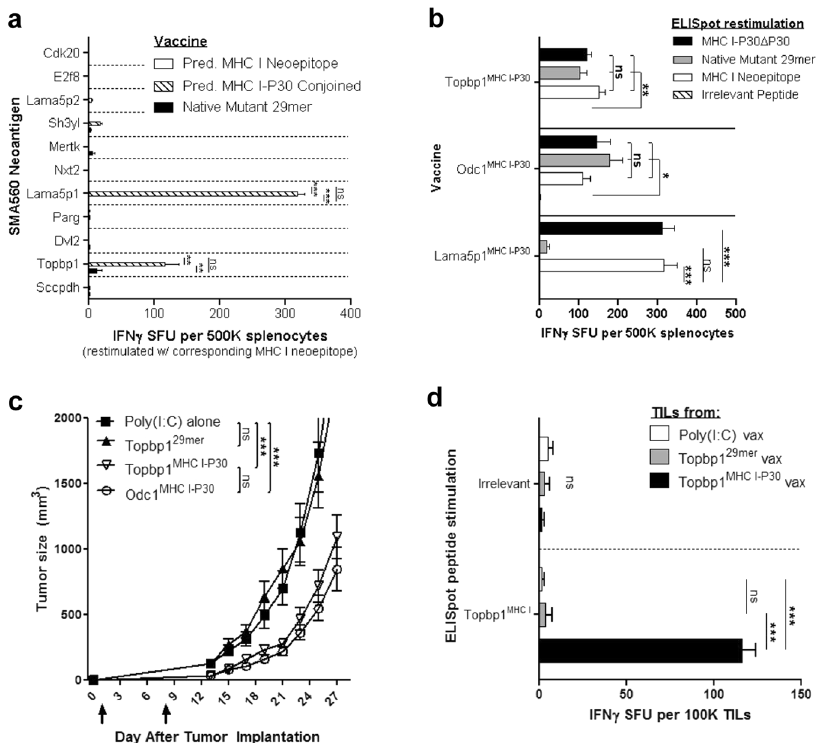
Fig. 3 Conjoined P30 can improve the therapeutic effects of neoantigen vaccines. a IFN γ ELISpot: splenocyte response to the corresponding putative MHC I-restricted neoepitope 7 days following immunization with the predicted MHC I-restricted neoepitope alone, the predicted MHC I-restricted neoepitope conjoined to P30, or the 29mer SLP spanning the endogenous neoantigen sequence ( n = 3). One-way ANOVA with post hoc Tukey ’ s test. b IFN γ ELISpot: mice ( n = 3) were immunized with Topbp1 MHC I-P30 , Odc1 MHC I-P30 , or Lama5 MHC I-P30 in order to induce a neoepitope-speci fi c CD8 + T-cell response. The ability of the MHC I neoepitope, MHC I-P30, or the native 29mer peptide to restimulate neoepitope-speci fi c CD8 + T cells was assessed 7 days following immunization. The response to